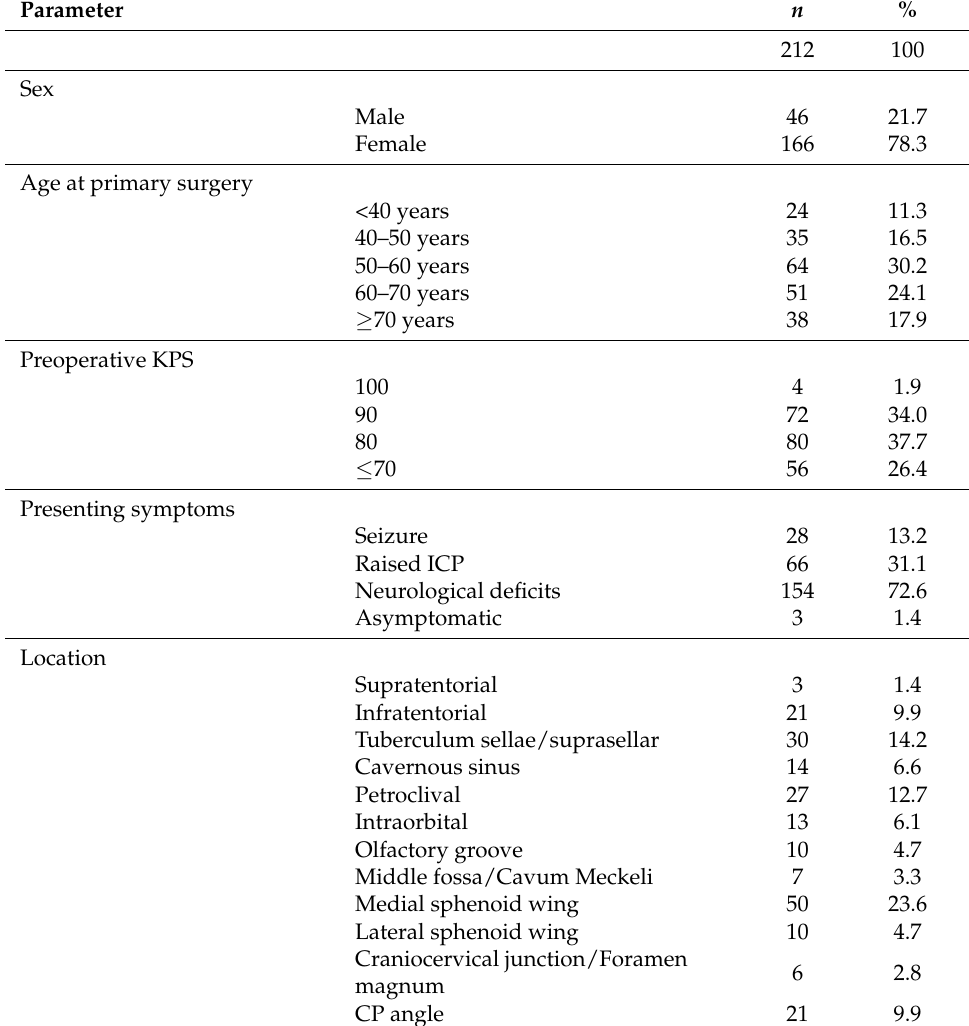
Table 1. Overall